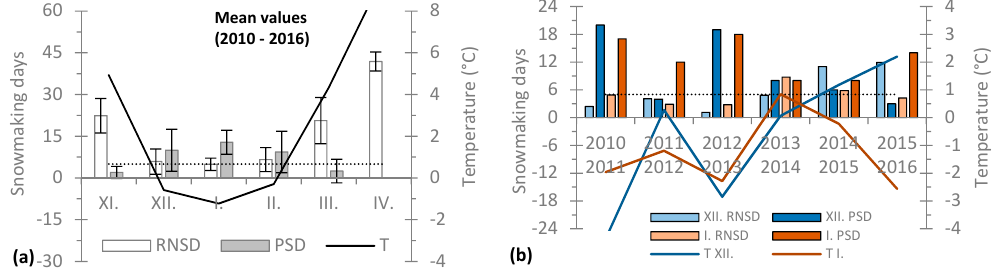
Figure 6. ( a ) The mean (±SD) number of potential snowmaking days (PSD) in contrast to the required number of snowmaking days (RND) and the monthly course of mean daily average temperature (T); ( b ) Seasonal values of PSD vs. RNSD and mean daily average temperatures in December and January. The horizontal dotted lines indicate the minimum number of five days for base layer snowmaking (20 cm thick).